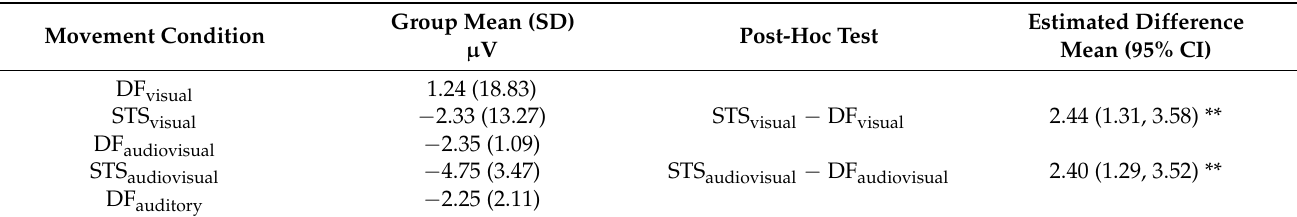
Table 2. Descriptive statistics and pairwise comparisons for PN amplitude.